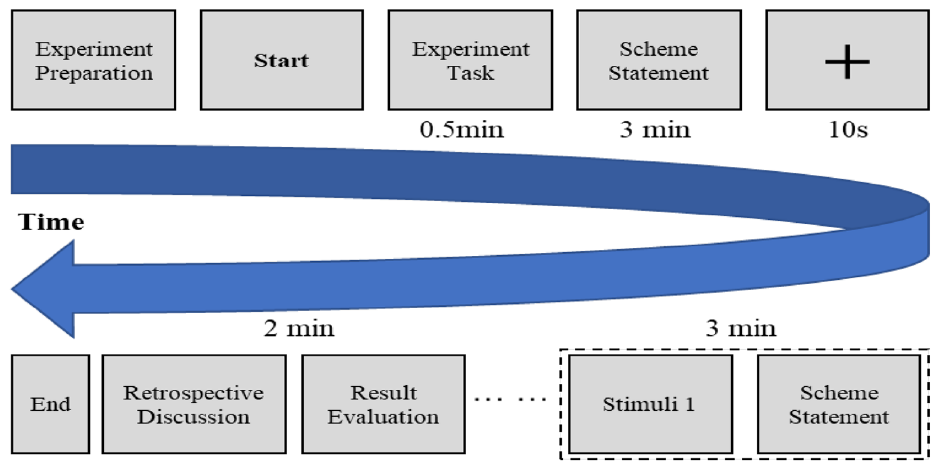
Figure 3. The analogy-inspired VPA experiment